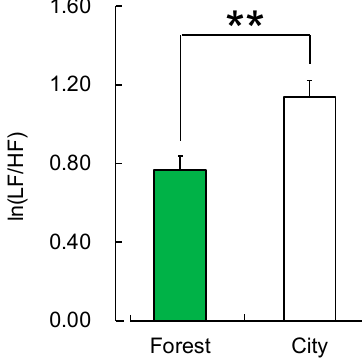
Figure 3. Natural logarithm of the heart rate variability low frequency / high frequency ratio, an indicator of sympathetic nervous system activity, while viewing forest and city areas. Data are presented as means ± standard error ( n = 65). ** p < 0.01, paired t -test (one-sided).